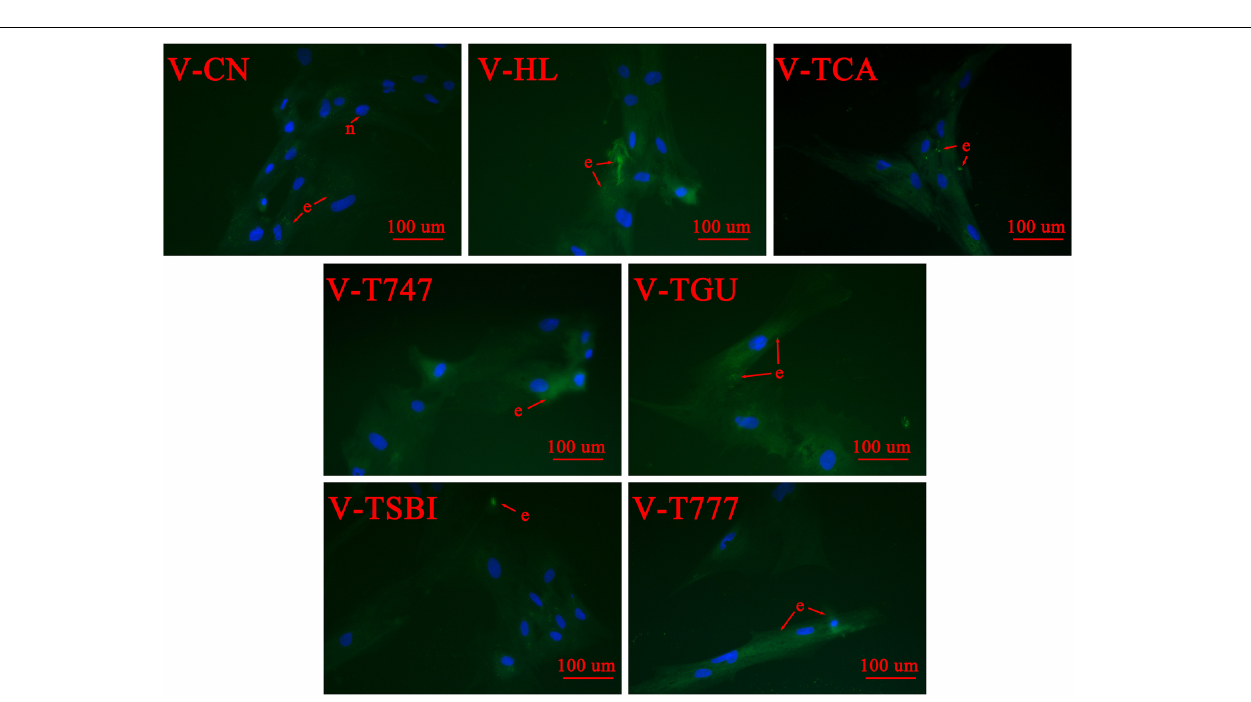
FIGURE 2 | The Bodipy 493/503 staining of different treatments in 400 × magnification ( n = 9). e, lipid droplets; n, nuclei. The lipid droplets are stained green and the nuclei are stained blue.